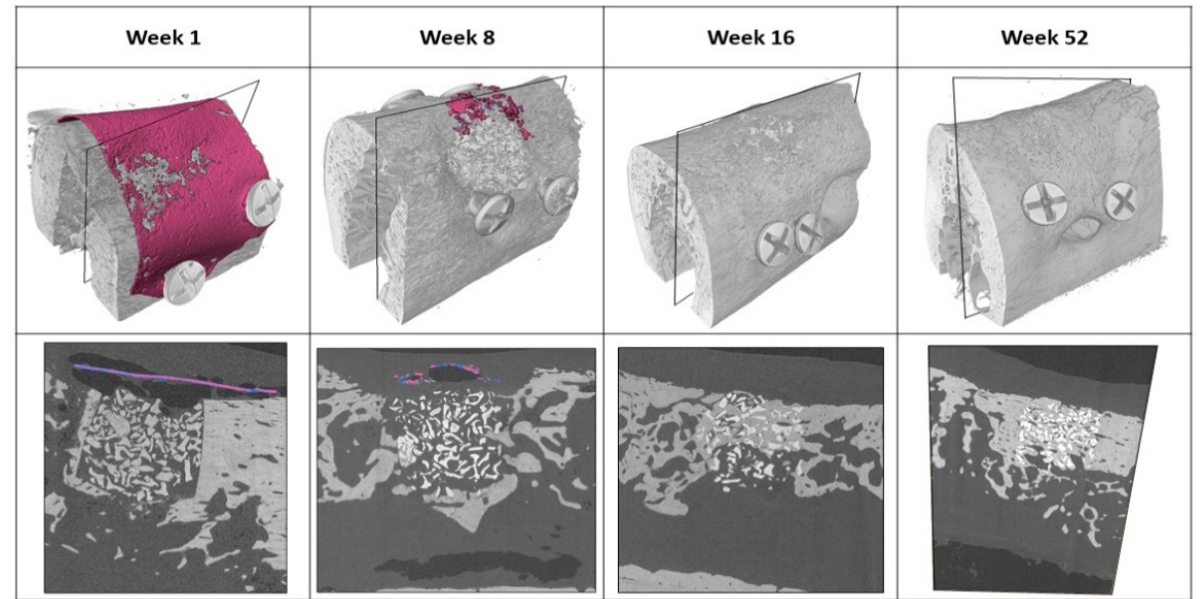
Figure 3. Reconstructed µ CT images showing the residual metallic magnesium membrane (indicated in pink and blue magnesium salts). Only a minor amount of the metallic magnesium is left after 8 weeks and is completely corroded at 16 weeks (in 11/12 samples). At 52 weeks after implantation, no residual of the remaining magnesium membrane could be observed, whilst the surrounding bone of the defect has fully integrated bone substitute